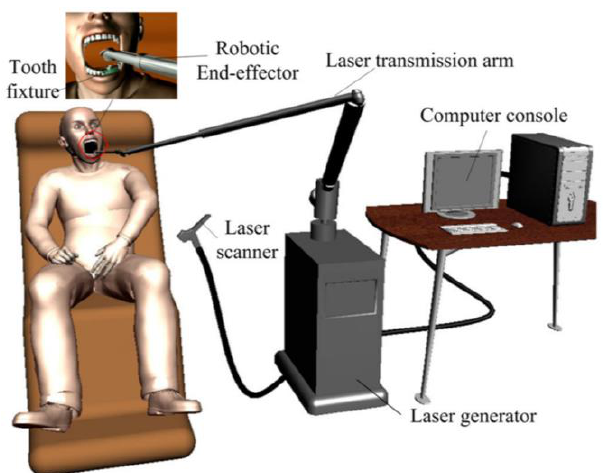
Figure 3. Conceptual illustration of the automatic crown preparation system [9].